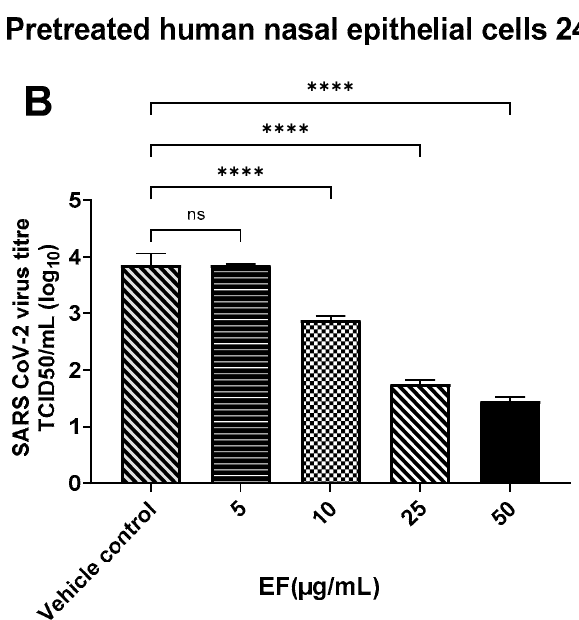
Figure 3. Infection preventive (antiviral) effect of EF on pretreated human airway epithelial cells. EF prevented OC43 ( A ) and SARS-CoV-2 (HU-1, B , C ) infection dose-dependently in pretreated HNEpC and HBEpC. Cells were pretreated with EF for 24 h and infected with virus at MOI of 1. Viral titer was measured at 72 h pi. Data resulted from 3 independent experiments. One-way ANOVA with Bonferroni multiple comparison correction was performed (****: p ≤ 0.0001). 3.3. Molecular Docking (MD) Herbal medicinal products typically contain a variety of pharmacologically active substances and in a first approach, several potentially active pharmacological substances were investigated for their interaction with well-known viral and cellular proteins in- volved in SARS-CoV-2 infection. Therefore, various alkylamide derivatives, caftaric acid, and 2-0-feruoyl-tartaric acid (totally 17 compounds) were tested for their docking poten- tial against 12 different target proteins of SARS-CoV-2 virus (3CLpro, PLpro, RdRp, S- protein, NSP9, NSP13-16) and human cell proteins (ACE2, TMPRSS-2, and JAK2). The structure of the S protein and its receptor-binding domain (RBD, shown in red color) is represented in Figure 4. The RBD of the S protein contains, i.e., 18 amino acid residues (K417, G446, Y449, Y453, L455, F456, A475, F486, N487, Y489, Q493, S494, G496, Q498, T500, N501, G502, Y505). Looking at the surface of the S protein, the active region of the protein has a cave-like domain, allowing ligands to adapt and fit into this domain (as shown in Figure 4).